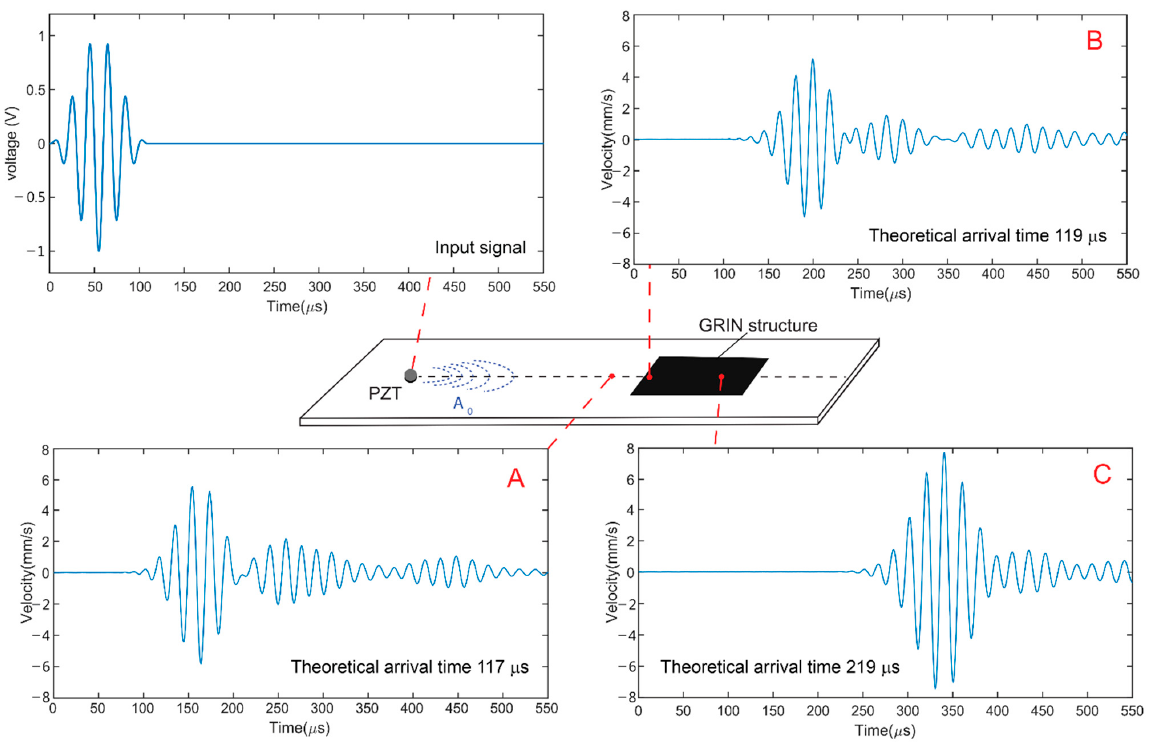
Figure 5. Input signal to the PZT actuator and LDV measurements of the z-direction velocity at three locations on the plate. locations on the